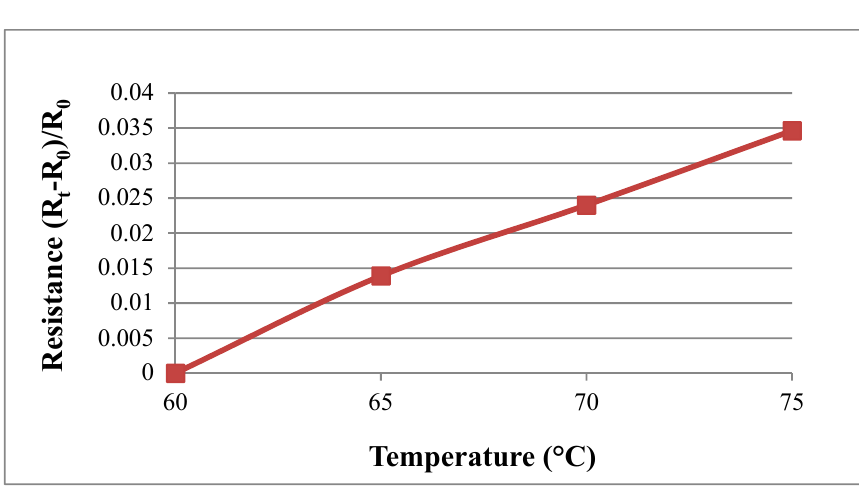
Figure 6. Schematic diagram of calibration of the flexible micro temperature sensor.